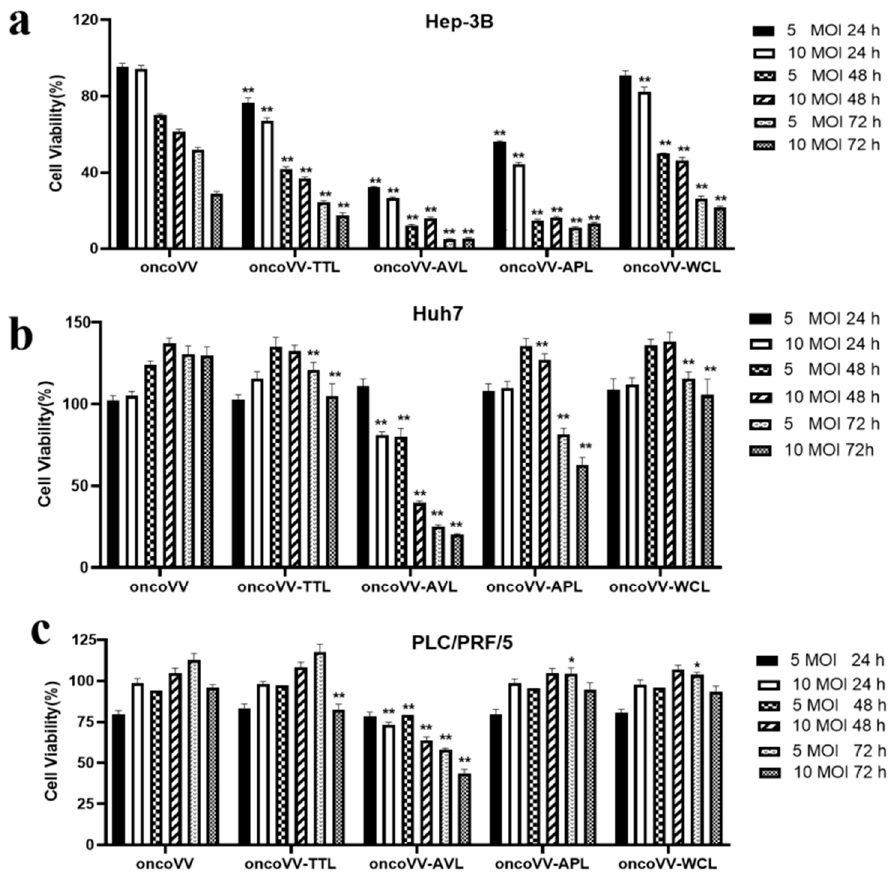
Figure 1. Percent viability (compared to PBS control) of HCC following infection with oncoVV-lec- tins. Cells were treated with PBS, oncoVV, or recombinant viruses at 5 or 10 MOI for 24, 48, or 72 h. Cell viability was measured by MTT assay in Hep-3B ( a ), Huh7 ( b ), and PLC/PRF/5 ( c ). OncoVV was used as the control. Values were calculated as the percentage of PBS control and presented as mean ± SEM (* p < 0.05, ** p < 0.01).